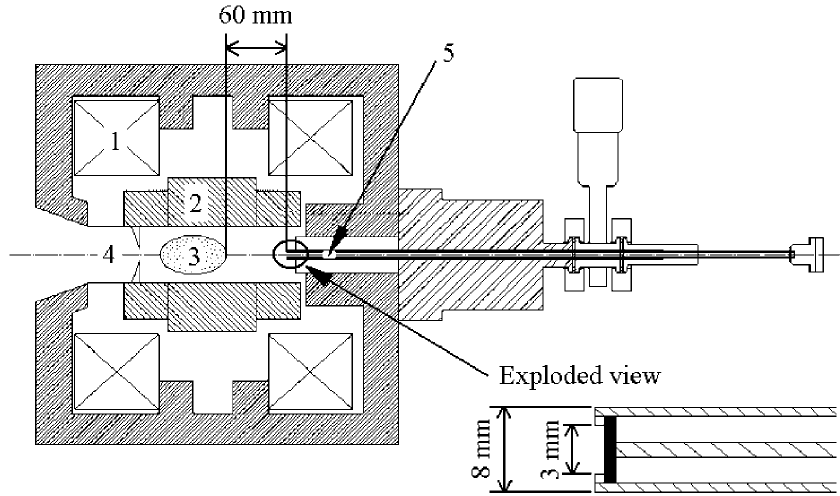
FIG. 1. Basic test setup with an ECR ion source chamber: (1) the coils, (2) the hexapole, (3) the ECR plasma surface, (4) the extractor, and (5) the ferroelectric cathode are